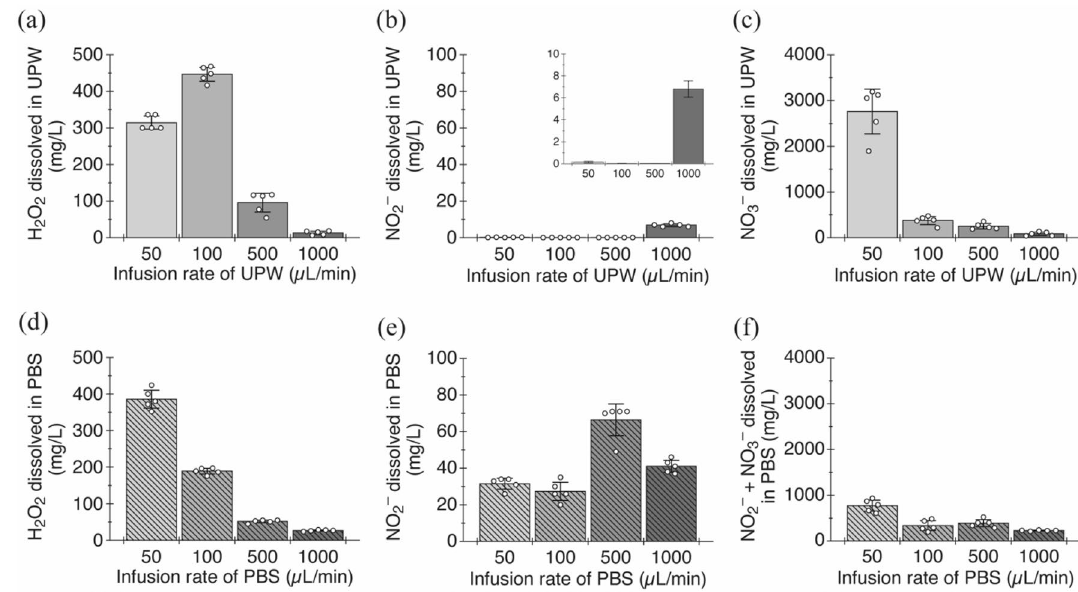
Figure 7. Chemical species in the nano-sized mist generated by the DBD. Concentrations of dissolved ( a, d )